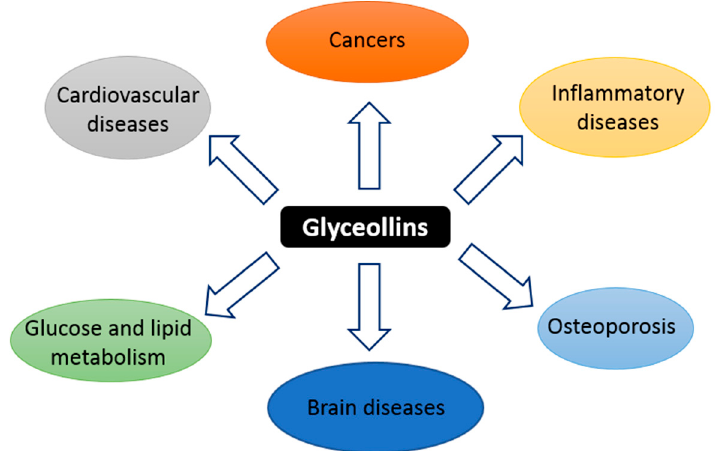
Figure 1. Schematic summary of the targets of glyceollins.